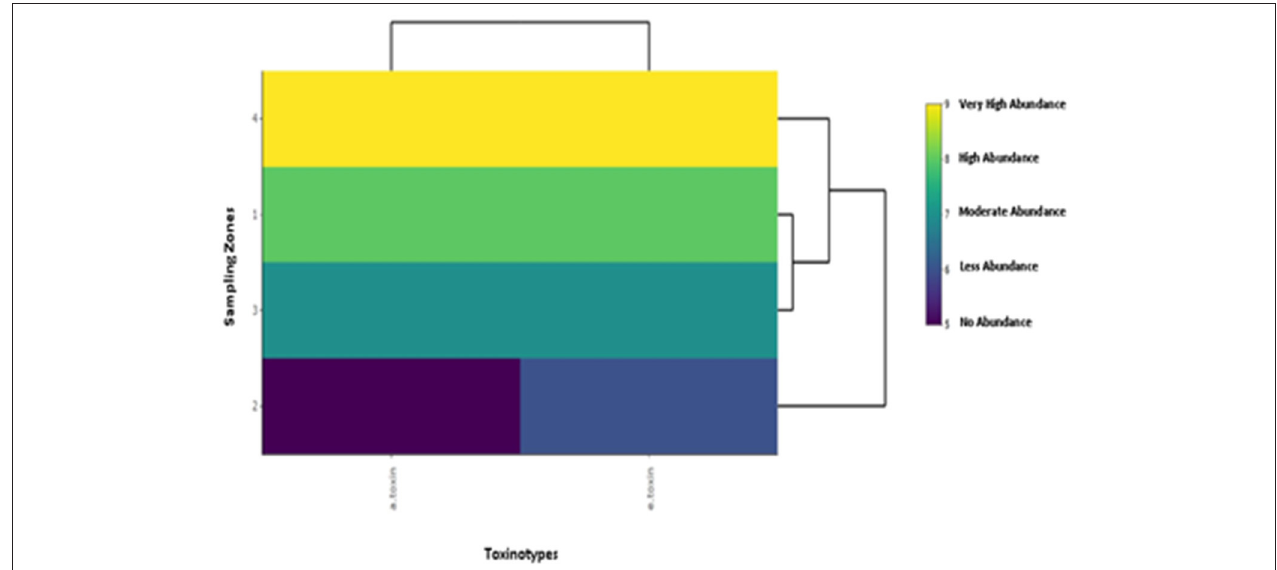
FIGURE 2 | Illustration of cluster analysis by heatmap of toxinotypes in C. perfringens isolated from buffalo and cattle in four different zones of Punjab province in Pakistan. The color scheme represents the abundance of toxinotypes in buffalo and cattle belonging to four sampling zones.